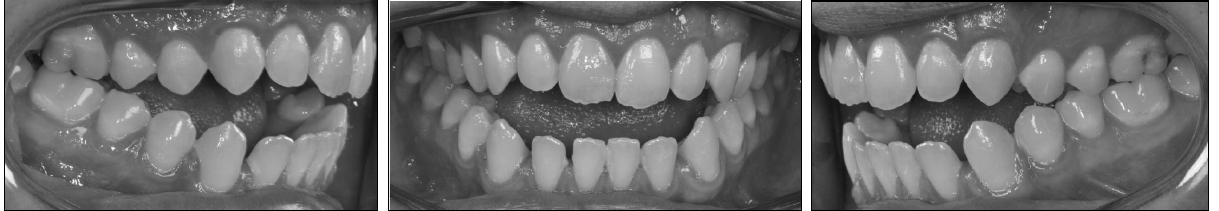
Figure 3. Pretreatment intra-oral